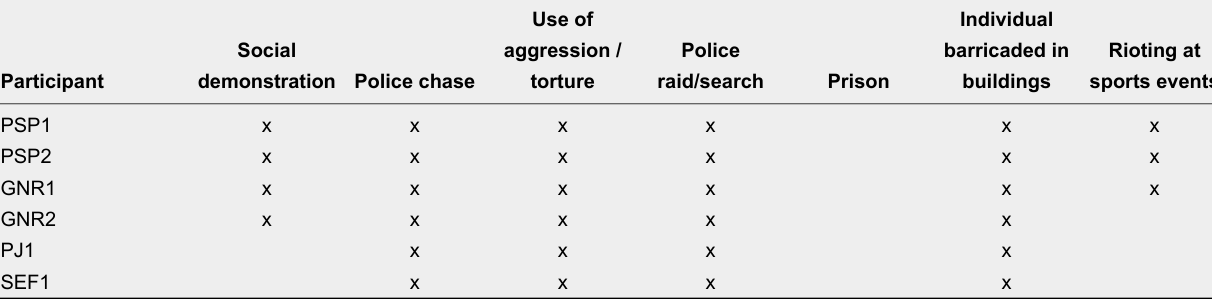
Scenarios Discussed per Participant